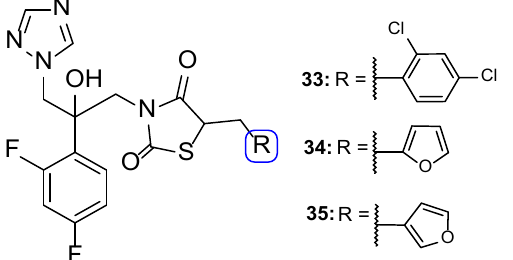
Figure 20. Chemical structures of triazole-thiazolidinedione hybrid compounds 33 – 35 [100]. The antimycotic 5-flucytosine is an agent utilized therapeutically in combination with other antifungal drugs, including azoles, due to its narrow spectrum, weak antifungal potential, and fast appearance of resistance mechanisms. As fluconazole has several good proprieties, such as good oral bioavailability and absorption, strong antifungal activity, broad spectrum, safety profile, and adequate PK, Fang et al. designed and synthesized new 5-flucytosine-fluconazole hybrids. Given that this combination of azoles with 5-flucytosine presented great antifungal activities, the authors decided to come up with a new series of hybrids, using the two different molecular scaffolds of 5-flucytosine and fluconazole, and study their antifungal potential. The main goal of this study was to exploit a new series of potential antifungal drugs, obtained to hopefully increase the spectrum of action and avoid resistance problems and adverse effects [101]. The synthesized compounds were tested for antifungal activity against C. albicans , C. parapsilosis , A. fumigatus , and C. tropicalis , using the broth microdilution method and 5-flucytosine and fluconazole as standards. The hybrid 36 (Figure 21) presented moderate to high antifungal potential (with MIC values ranging from 40 to 170 µ M) when compared to the drugs used as positive controls, fluconazole and 5-flucytosine (with MIC values ranging from 3 to 1650 µ M and 30 to 1980 µ M, respectively). These values suggest that the hybridization was successful, meaning it favored the antifungal activity [101].